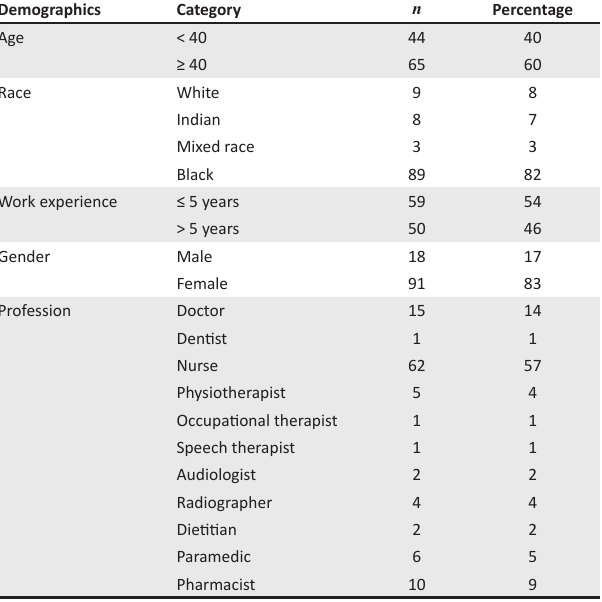
TABLE 1: Participants’ demographic profiles.